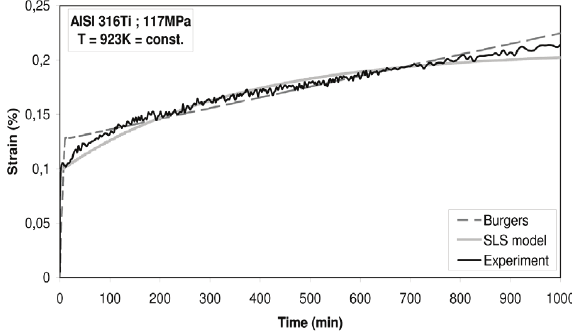
Figure 7. Experimentally obtained and modeled creep curves: AISI 316Ti steel (Burgers model and SLS model), (cid:2) D 117 MPa, T D 923 K, t D 1000